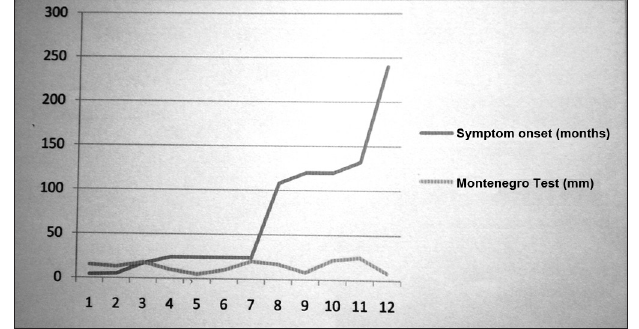
Graph 1. Correlation between the Montenegro test and symptom onset - Papule diameter in the Montenegro skin test and clinical symptom evolution time of the mucosal leishmaniasis of patients seen in the Otorhinolaryngology Clinic of the University Hospital between April 2008 and April of